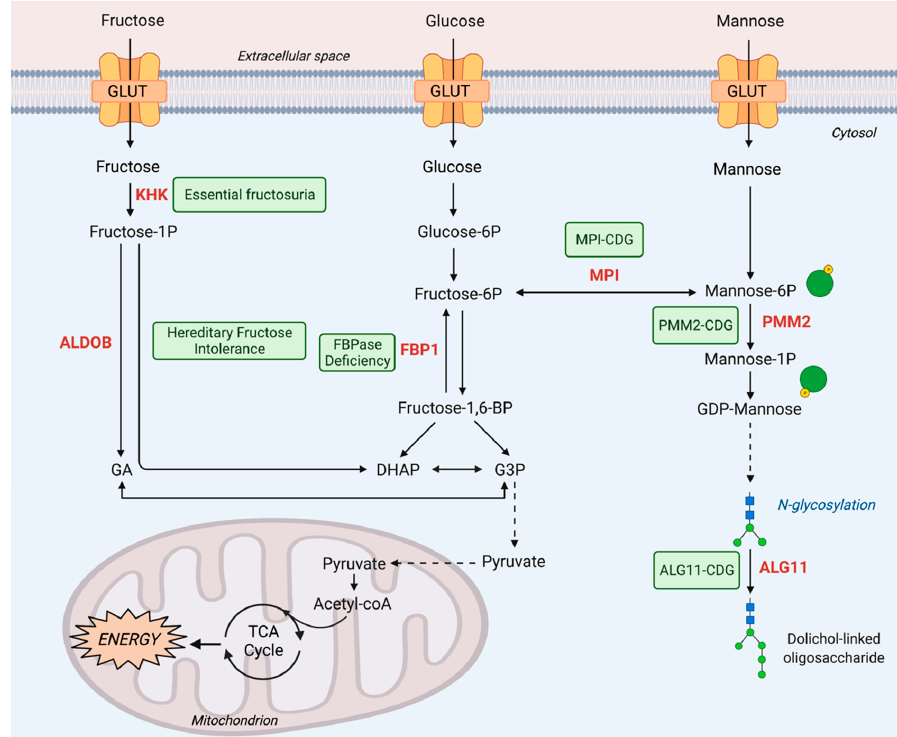
Figure 1. Fructose and mannose inborn errors of metabolic disease. A number of inborn errors are related to perturbed sugar metabolism, including fructose and mannose. Fructose and mannose transport occurs through glucose transporters due to their similarity in structure. Essential fructosuria and hereditary fructose intolerance affect fructolysis through deficiency in KHK and ALDOB, respectively. These pathways feed into the glycolysis pathways through GA to G3P conversion and DHAP production. FBPase deficiency affects fructose metabolism by loss of FBP1 activity blocking gluconeogenesis. Mannose metabolism, which is linked to fructose metabolism by the enzyme MPI, is also subject to mutations causing inborn errors. The central role of mannose in glycosylation explains the inborn errors classified as congenital disorders of glycosylation. MPI-CDG, PMM2-CDG, and ALG11-CDG relate to the deficiency of the enzyme listed in their names causing hypoglycosylation. These changes affect proper protein folding, leading to aberrant cellular function. Types of inborn errors of metabolism are shown in light green boxes. Proteins: GLUT, Glucose transporter; KHK, Ketohexokinase; ALDOB, Aldolase B; FBP1: Fructose-1,6-bisphosphatase 1; MPI: Mannose phosphate isomerase; PMM2: Phosphomannomutase 2; ALG11: GDP-Man:Man3GlcNAc2-PP-dolichol-alpha1,2-mannosyltransferase; Metabolites: GA; Glyceraldehyde; DHAP: Dihydroxyacetone phosphate; Fructose-1P: Fructose-1-phosphate; Glucose-6P: Glucose-6-phosphate; Fructose-6P: Fructose- 6-phosphate; Fructose-1,6BP: Fructose-1,6-bisphosphate; Mannose-6P: Mannose-6-phosphate; Mannose-1P: Mannose- 1-phosphate; GDP-mannose: Guanosine diphosphate mannose; G3P, Glyceraldehyde-3-phosphate; Pathways: TCA, tricarboxylic acid; Disease: CDG: Congenital disorders of